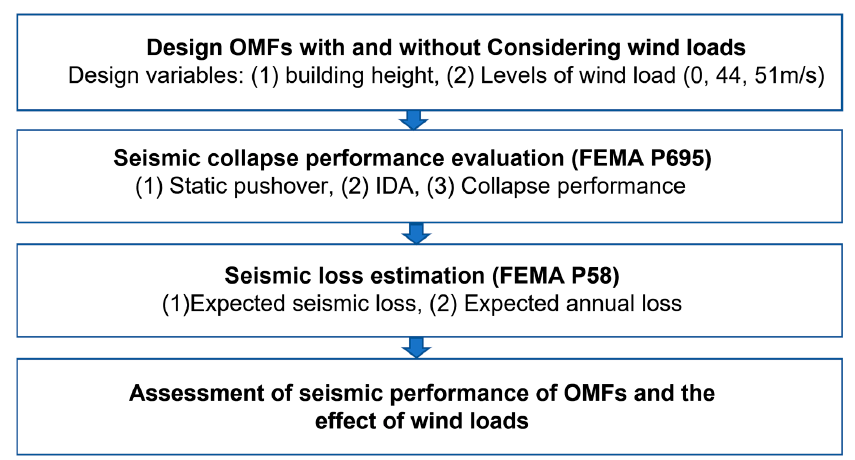
Figure 1. Methodology of this study.